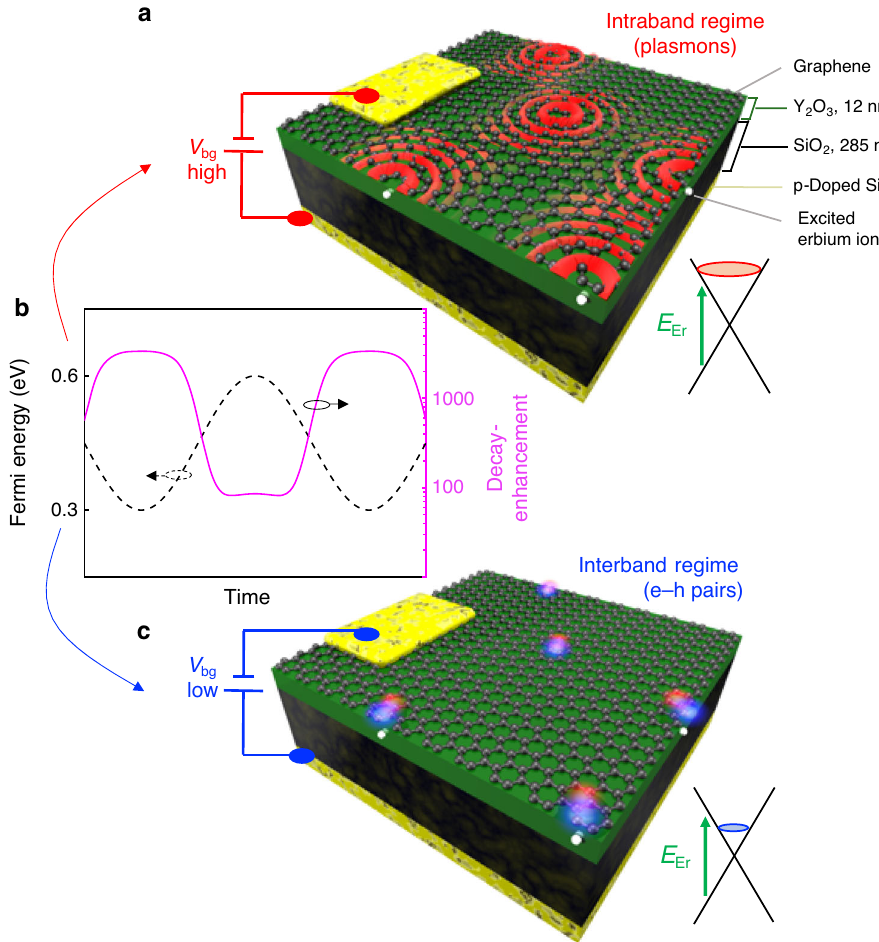
Fig. 1 Concept of dynamic modulation of hybrid erbium – graphene system. a Schematic illustration of the hybrid erbium – graphene system when the Fermi energy of graphene is tuned to ~0.6 eV and the erbium – graphene interaction leads to intraband transitions, mainly associated with launching of propagating graphene plasmons (red waves). The system contains, from top to bottom, a monolayer of graphene, a thin fi lm (~12 nm) of Y 2 O 3 containing erbium ions (white spheres), a 285-nm-thick SiO 2 layer, and a p -doped silicon backgate. A backgate voltage, V bg , is applied between the backgate and a gold electrode in contact with graphene for fast modulation. The SiO 2 layer serves as electrical isolation between graphene and the p -doped silicon. On top of graphene, there is a transparent topgate made of polymer electrolyte (not shown in the image). b Sinusoidal time evolution of the Fermi energy of graphene (dashed black line, left vertical axis) and the corresponding decay-enhancement factor F P for an erbium emitter located at z = 5 nm from graphene (solid purple line, right vertical axis). The modulation of the Fermi energy, calculated following refs. 28,29 , leads to a modulation of F P by more than one order of magnitude — from <100 in the intraband regime to >1000 in the interband regime. c Schematic illustration of the hybrid erbium – graphene system for E F ~ 0.3 eV, which corresponds to interband transitions, mainly creating electron – hole pairs (red – blue